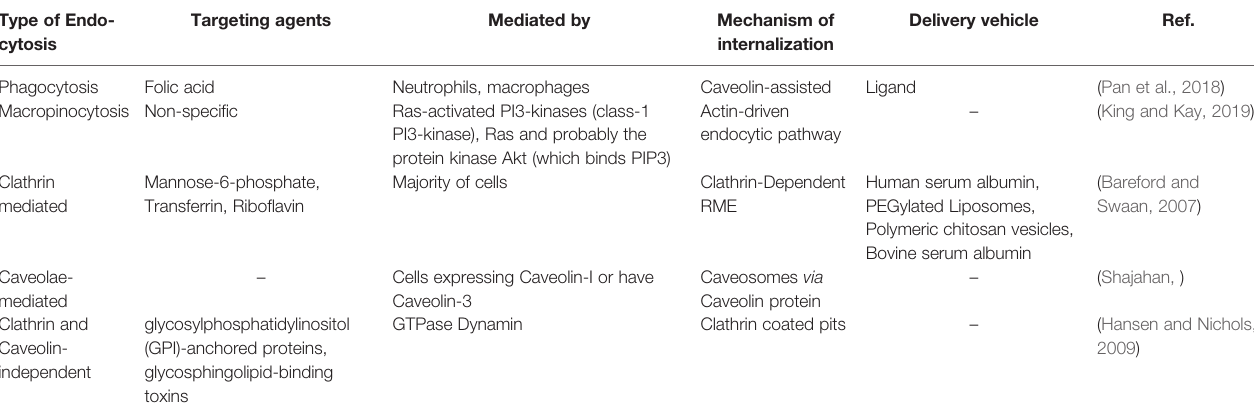
TABLE 1 | List of endocytosis pathways and targeting